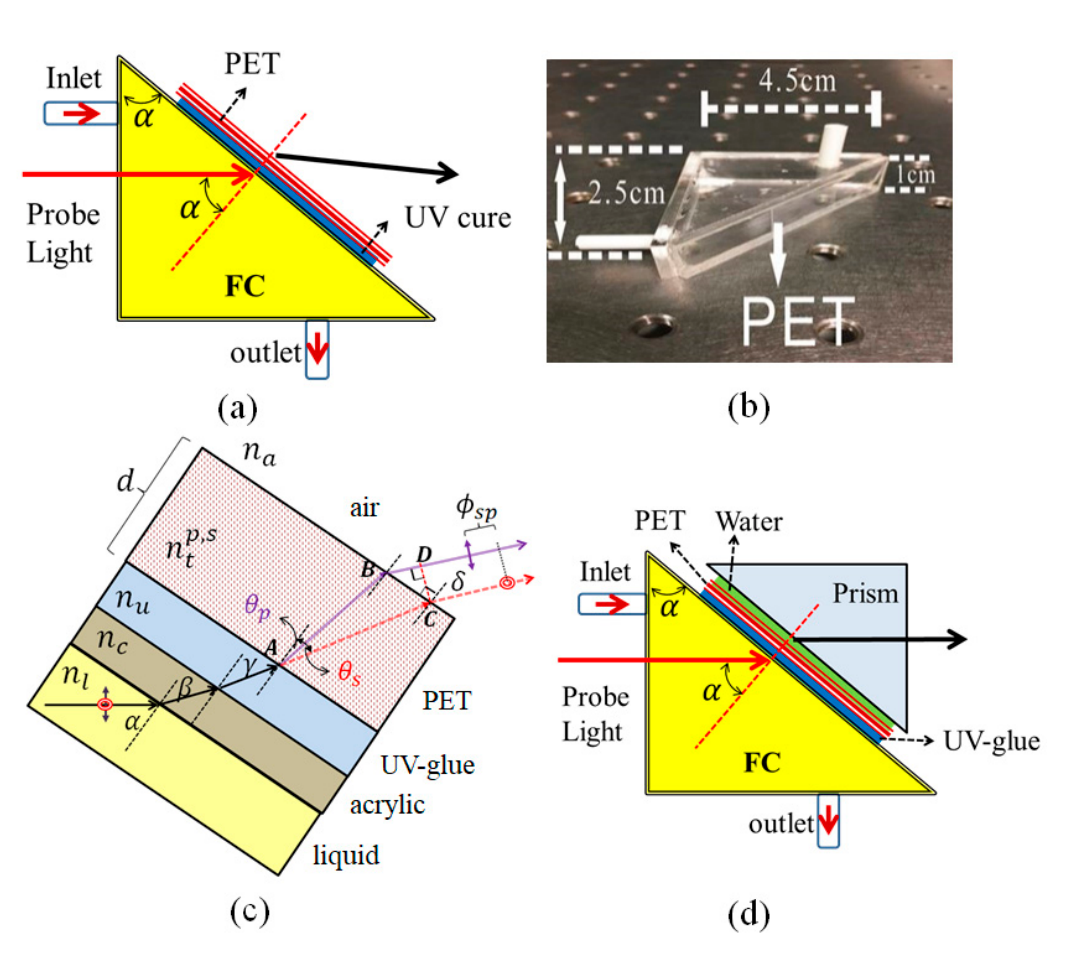
Figure 1. Schematic diagram of the sensing principle. ( a ) Birefringent polyethylene terephthalate (PET) fluidic sensor. ( b ) Photo of PET-FS. ( c ) The optical path for two orthogonal polarizations. ( d ) Prism coupling onto the FET-FS.